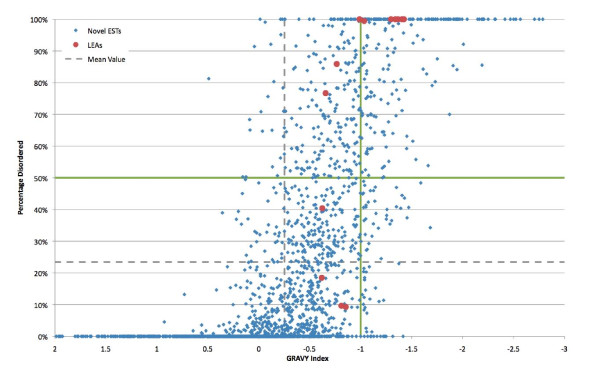
A plot of the hydropathy value (GRAVY Index) [111]of P. superbus putative novel peptides and the 13 predicted P. superbus LEA proteins against their predicted degree of disorder, as determined by the IUPred program [110]. (GRAVY = Grand average of hydropathicity); hydrophilic proteins typically have hydropathy values < -1 [154]. Green lines represent the boundaries that delimit a group of novel hydrophilic peptides that are predominantly disordered.